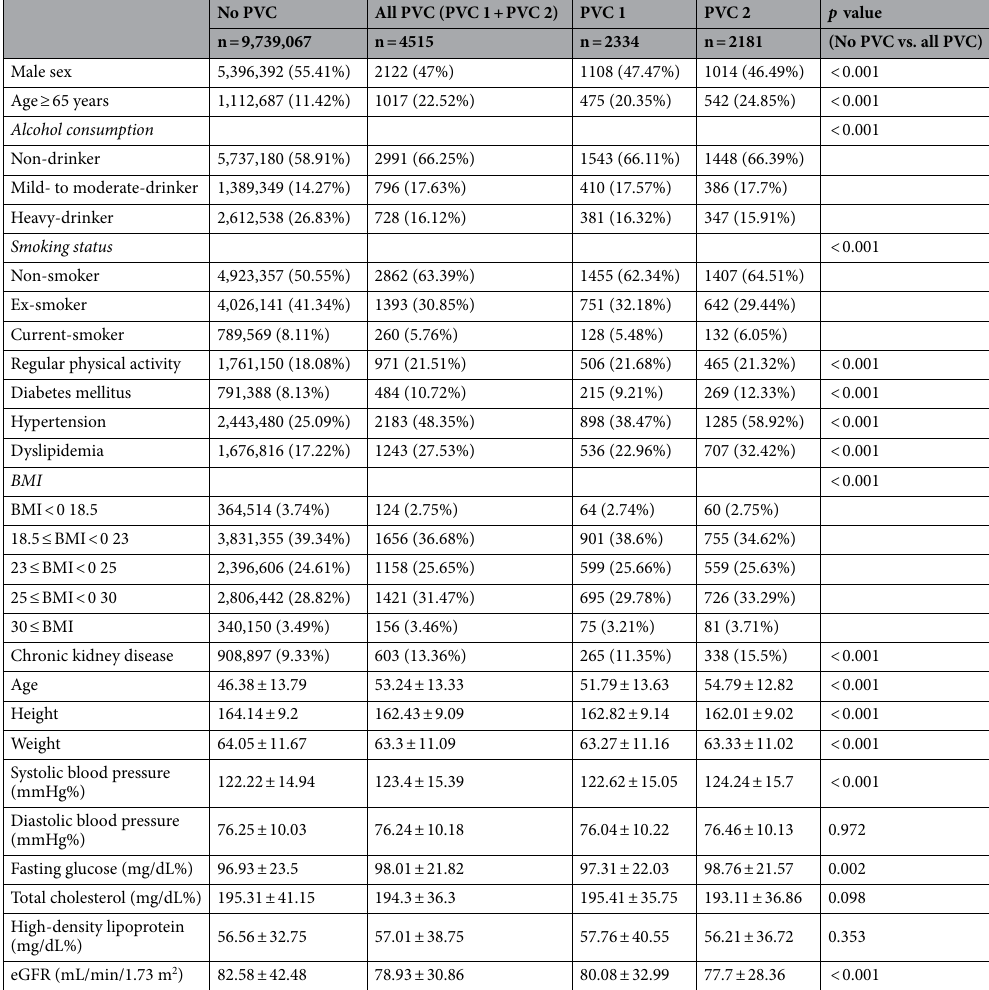
Table 1. Baseline demographics of patients with and without PVC. BMI body mass index, eGFR estimated glomerular filtration rate, PVC premature ventricular contraction.